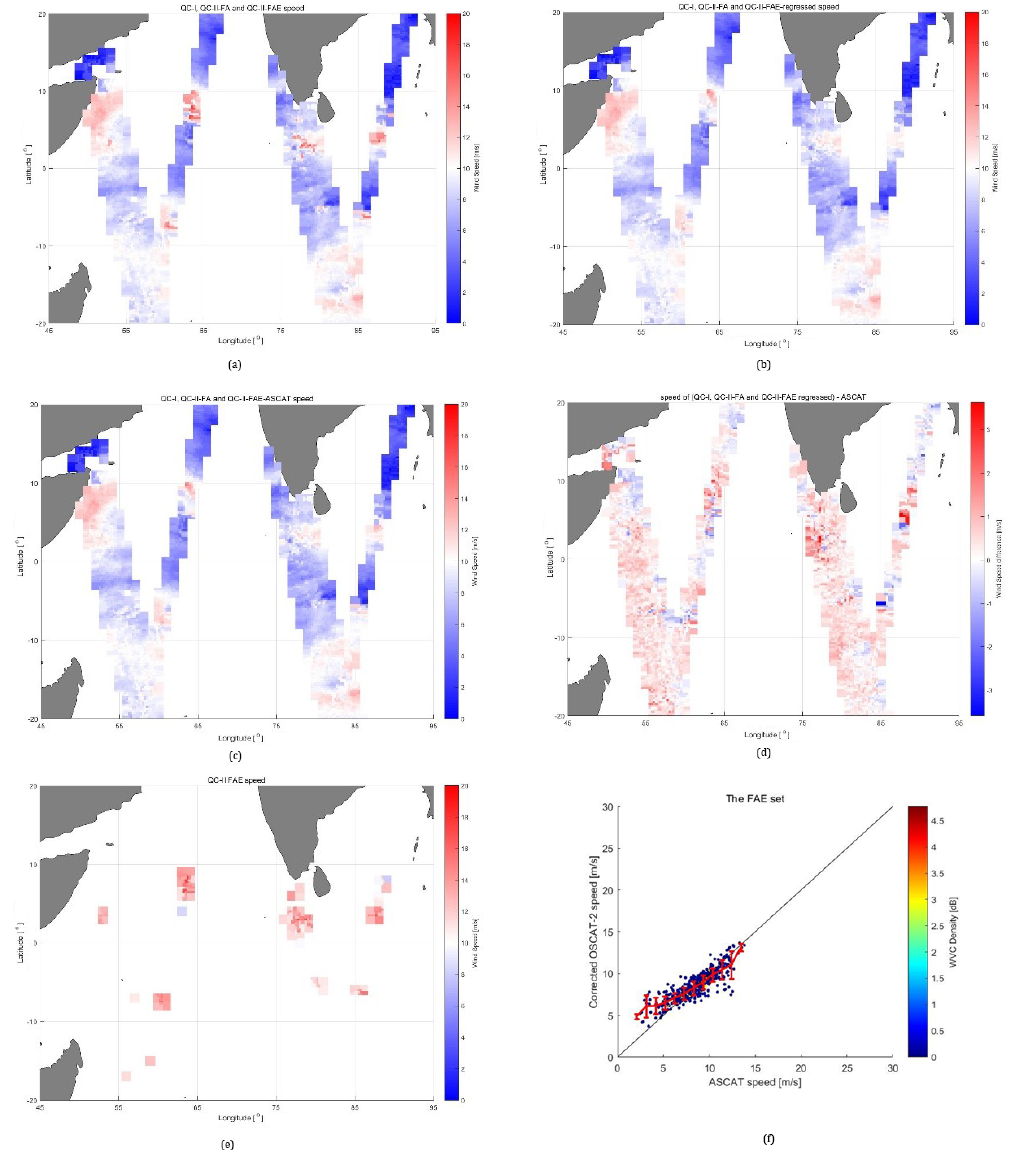
Figure 6. OSCAT-2 speed (m/s, in colour bars) for QC-I collocation set FA and FAE in the QC-II set (a) , and that of the QC-I, QC-II FA set when the FAE values in QC-II are replaced SVM regressed speeds (b) ; then the FAE wind speeds are substituted by collocated ASCAT-A and ASCAT-B speeds (c) . Panel (d) shows the differences of speeds in (c) with their corresponding ASCAT speed, and (e) indicates the FAE location, while (f) shows the statistics of the corrected wind with ASCAT